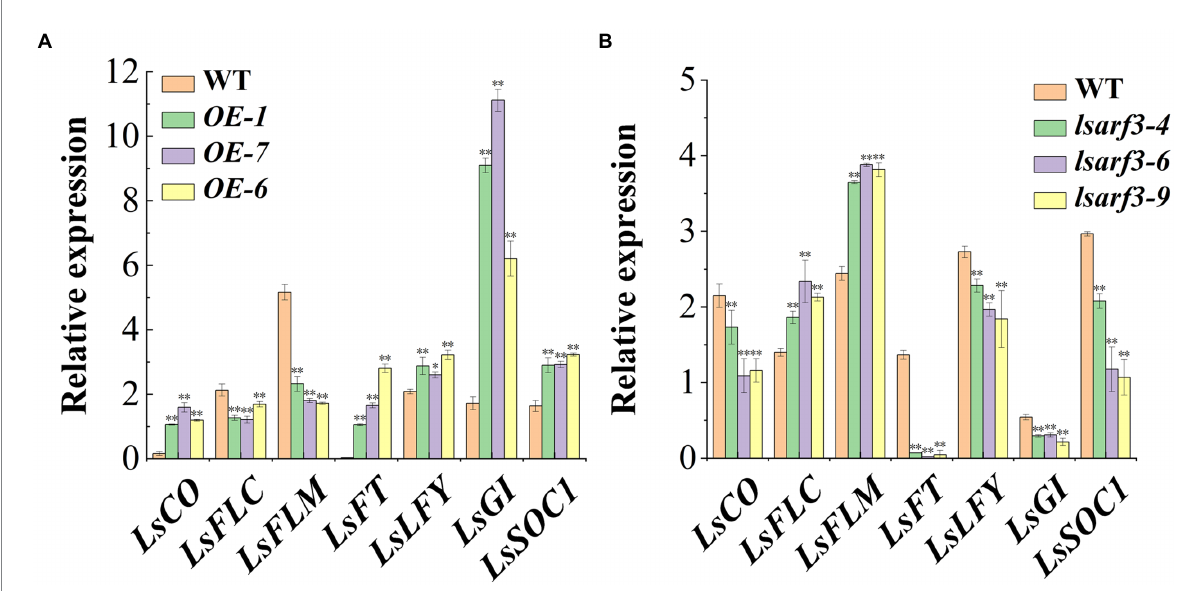
FIGURE 5 Transcript levels of flowing related genes in WT, LsARF3 -OE and lsarf3 mutants. (A) Expression levels of flowering related genes in WT and LsARF3 - OE lines. (B) Expression levels of flowering related genes in the WT and lsarf3 mutants. Significant differences were tested by Student’s t -test (*indicates p < 0.05 and **indicates p <